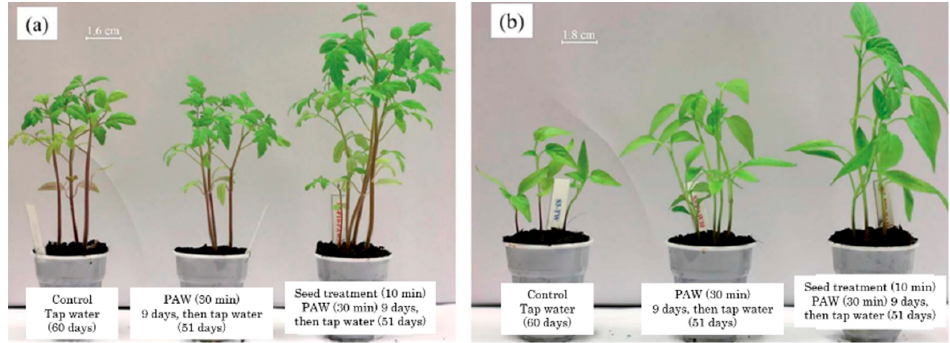
Figure 17. Long term effect of seed treatment by plasma and PAW on ( a ) tomato and ( b ) pepper plant growth. Reprinted from [286].